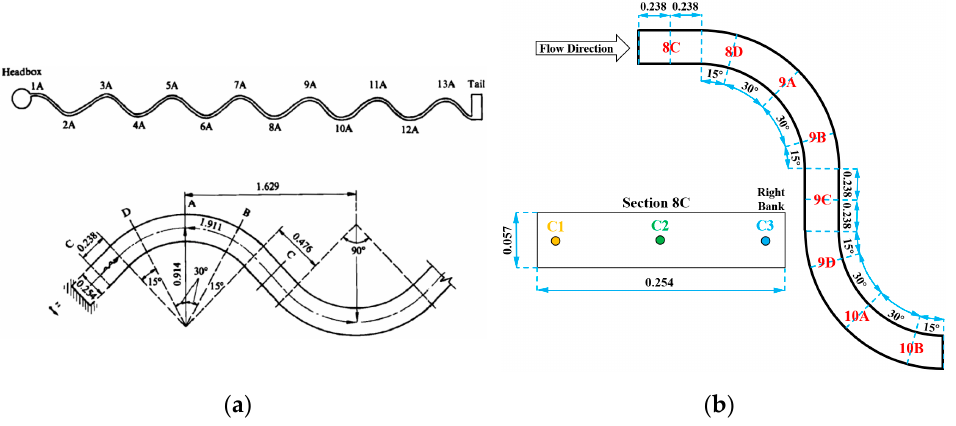
Figure 1. Sketch of the flume (Dimensions in meter): ( a ) plane view (adapted from Chang [5]); ( b ) geometry of a meander and the release positions of point source tracer of C1, C2, and C3. Table 1. Hydraulic parameters of the experiment.